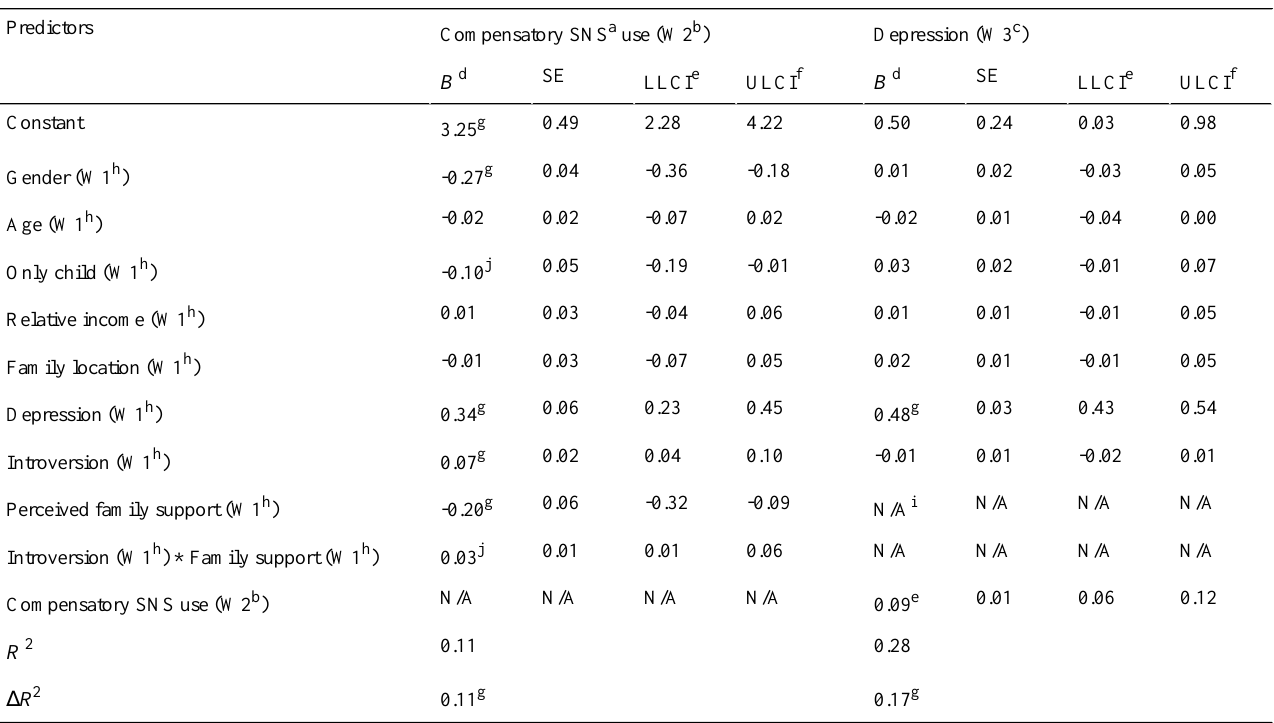
Table 2. Results of moderated mediation analysis (N=1137).